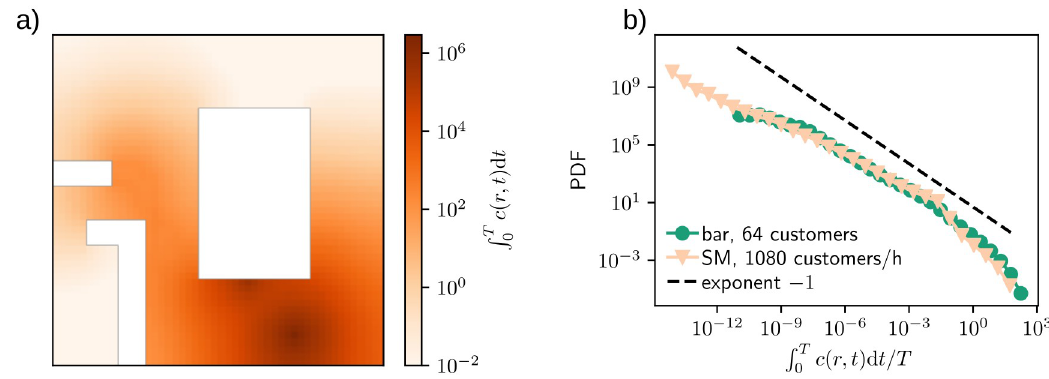
Fig 7. (a) The aerosol concentration summed through one single bar simulation. (b) The distribution of cell values seen in (a) divided by the corresponding simulation duration T collected from all of the